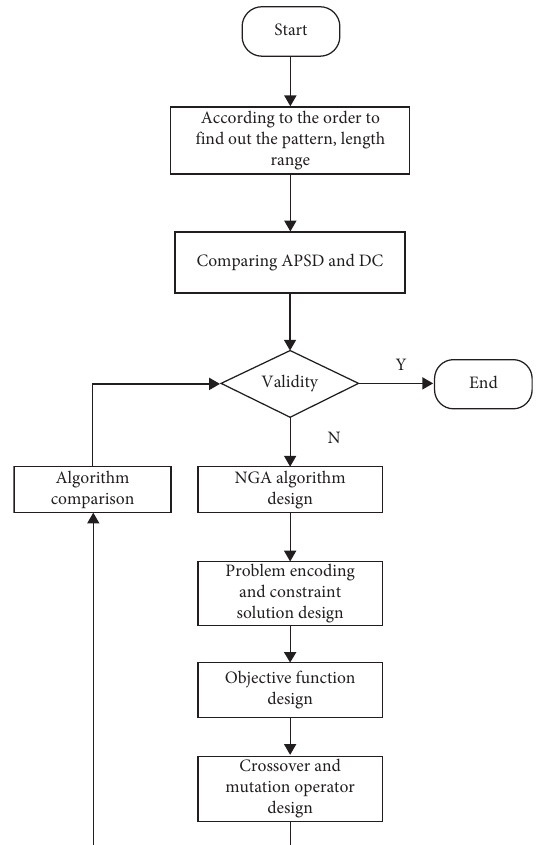
Figure 2: Blanking decision scheme design fow diagram.